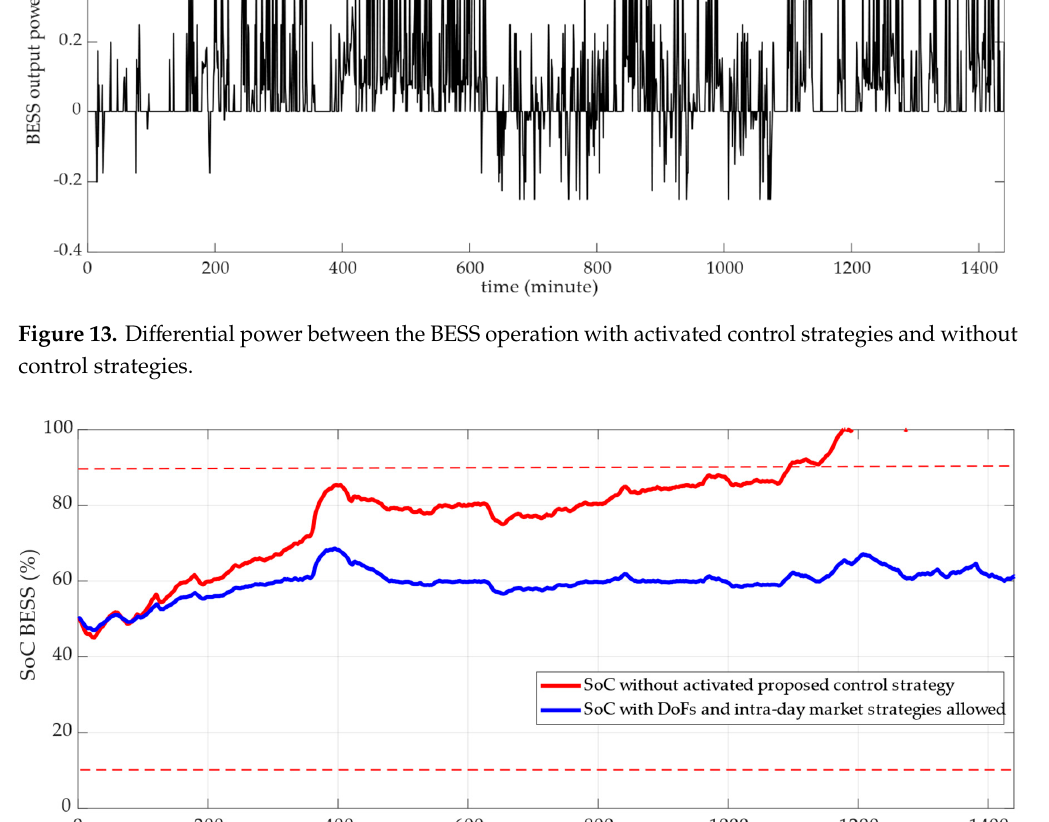
Figure 14. Impact of the use of the proposed SoC control strategy on the charge level of the BESS.